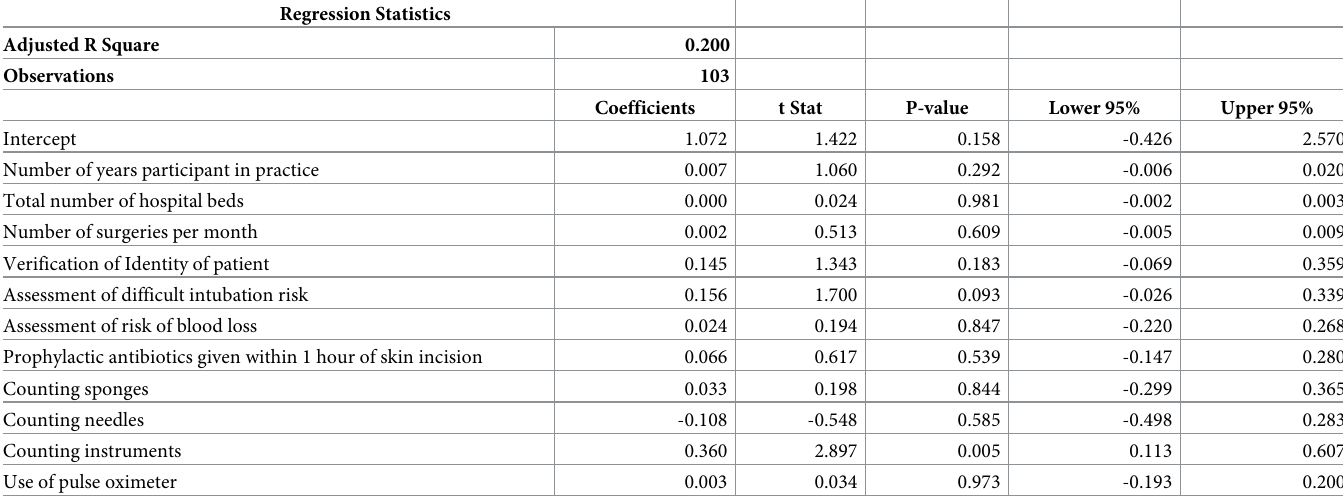
Table 5. Multivariate linear regression results with checklist use as the dependant